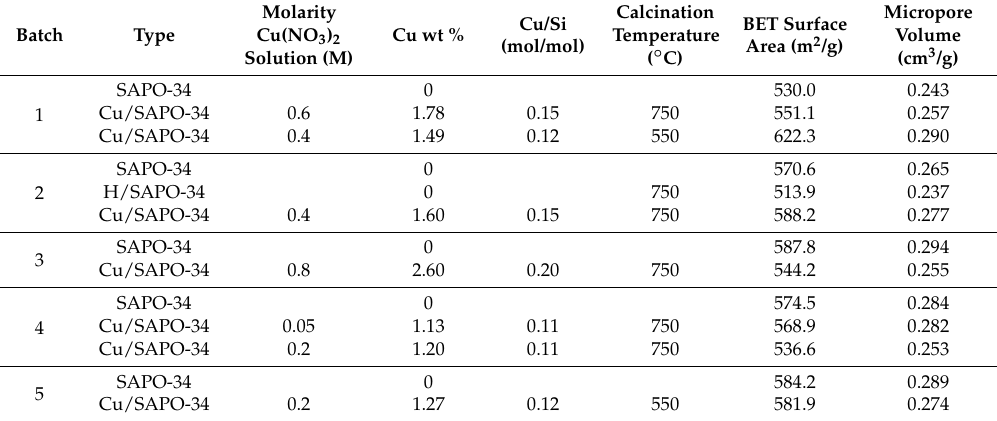
Table 1. Catalysts synthesised in this study. All catalysts are shown with the corresponding